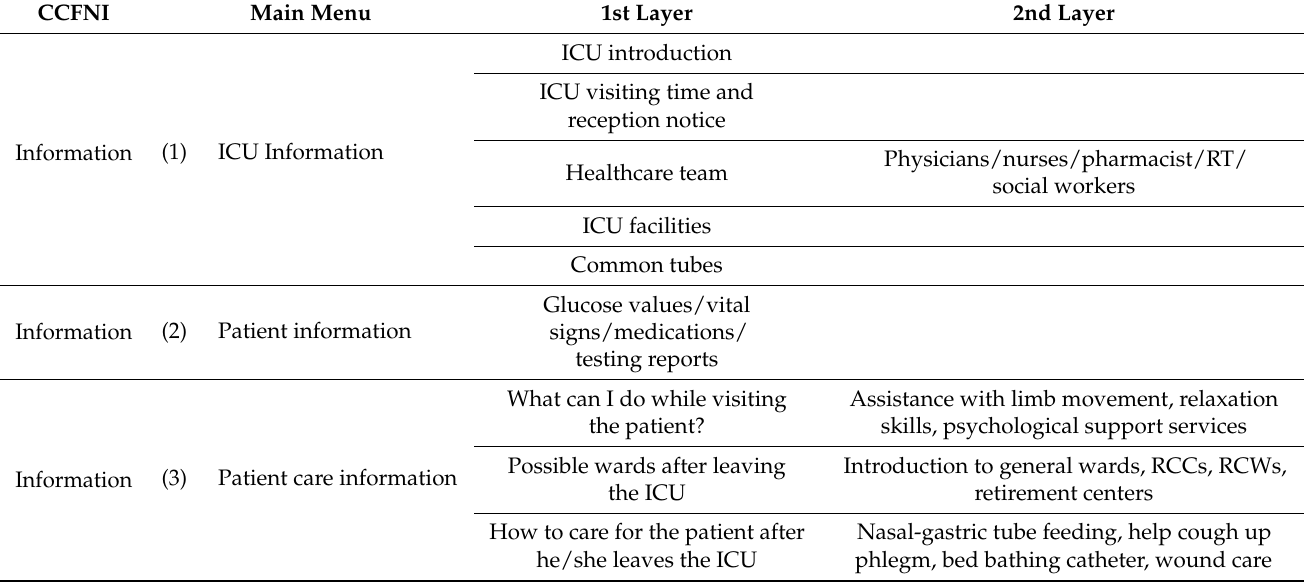
Table 1. Functions of the